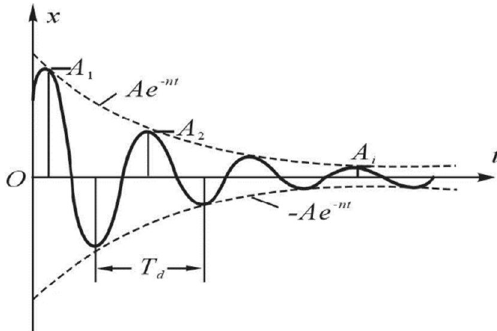
Figure 3. Schematic diagram of free decay